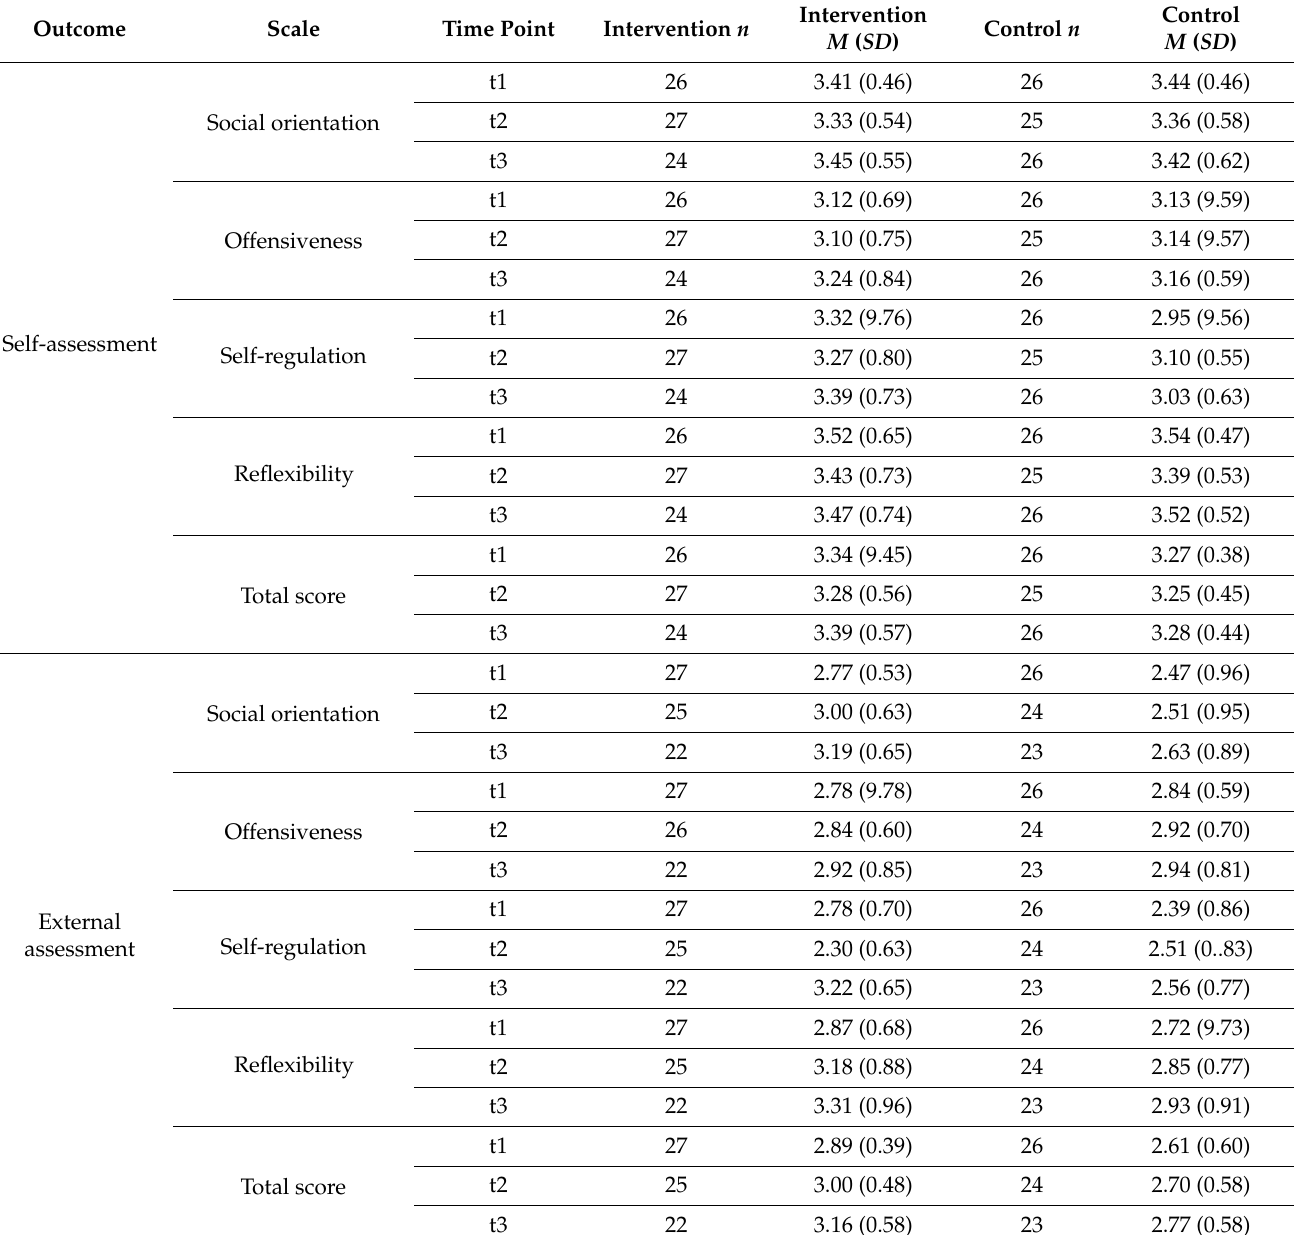
Table 3. Development of social competences over time for the intervention and the control